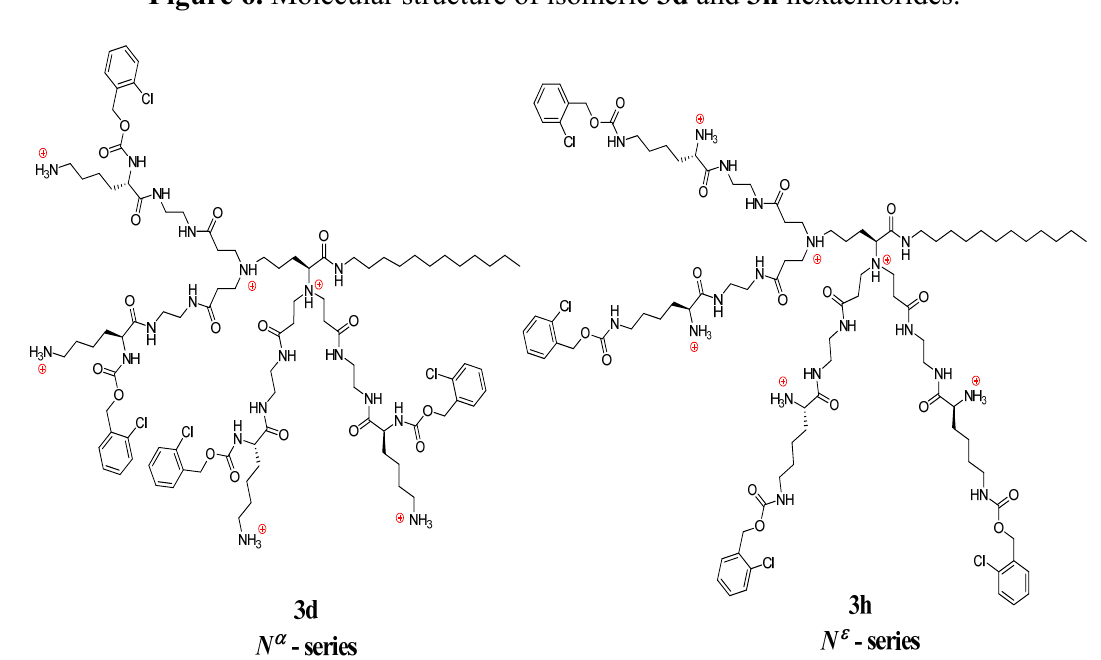
Figure 6. Molecular structure of isomeric 3d and 3h